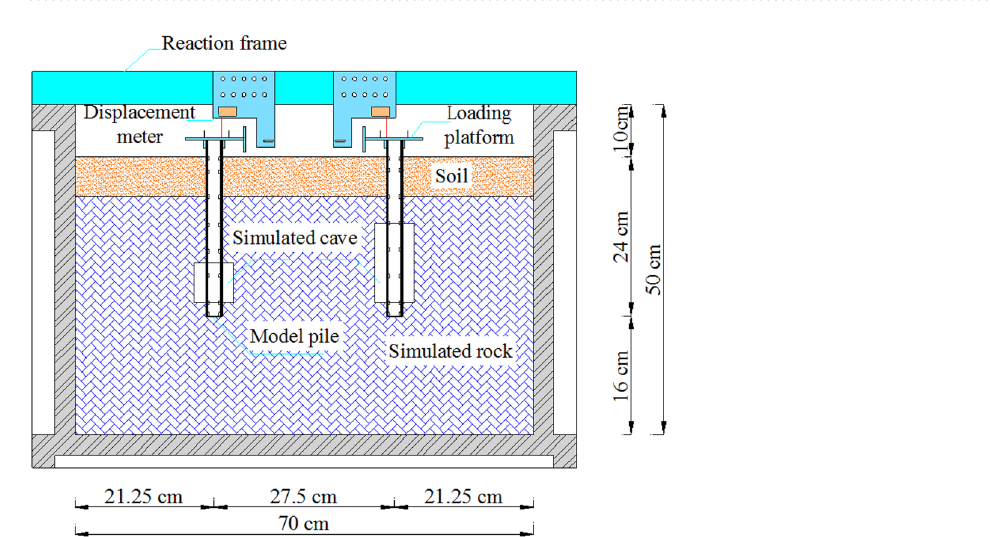
Figure 16. Model